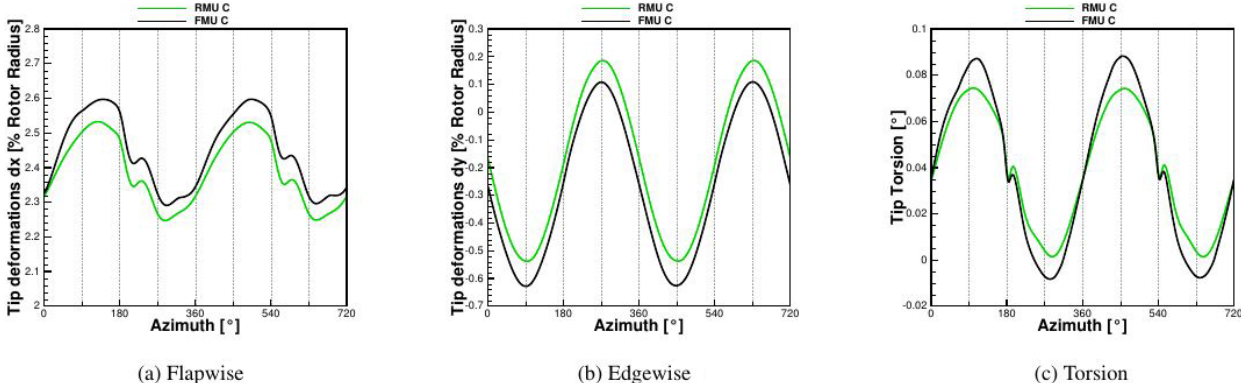
Figure 9. Tip deformations calculated with CFD at 6.1ms − 1 comparing RMU vs. FMU.